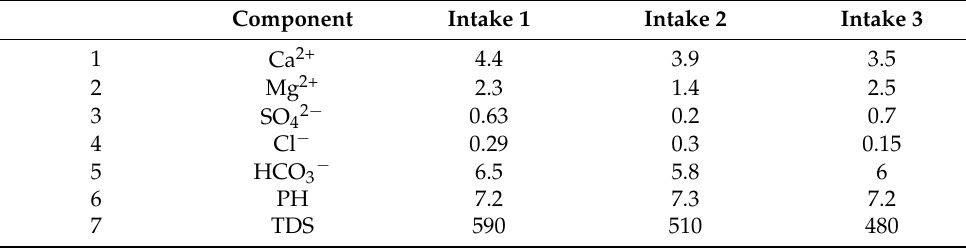
Table 1. Ground water composition in different intakes (Moscow